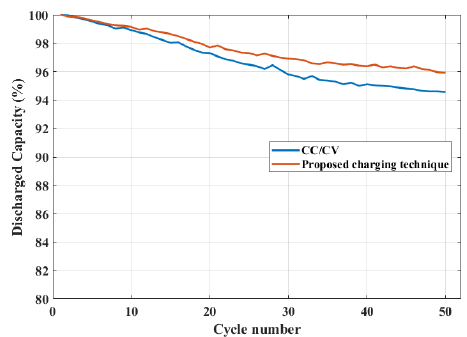
Figure 18. Comparison of cycle life tests between the proposed and the CCCV technique.